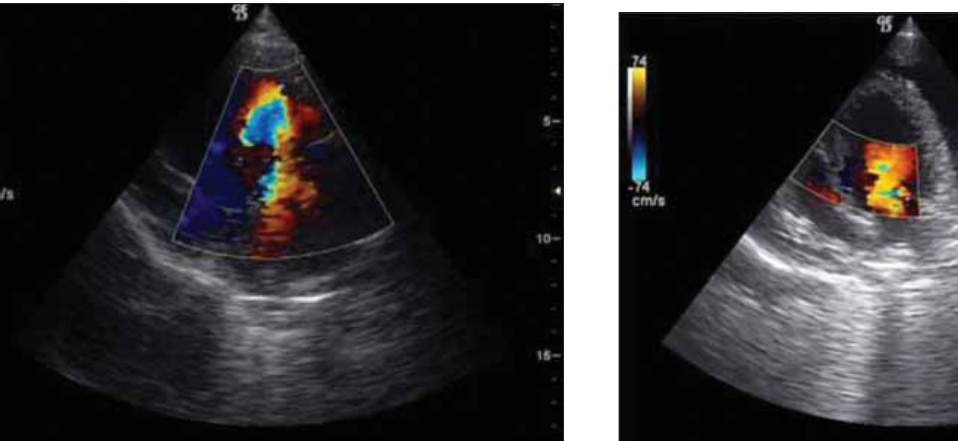
Figure-5: Regurgitation at the level of aortic valve.